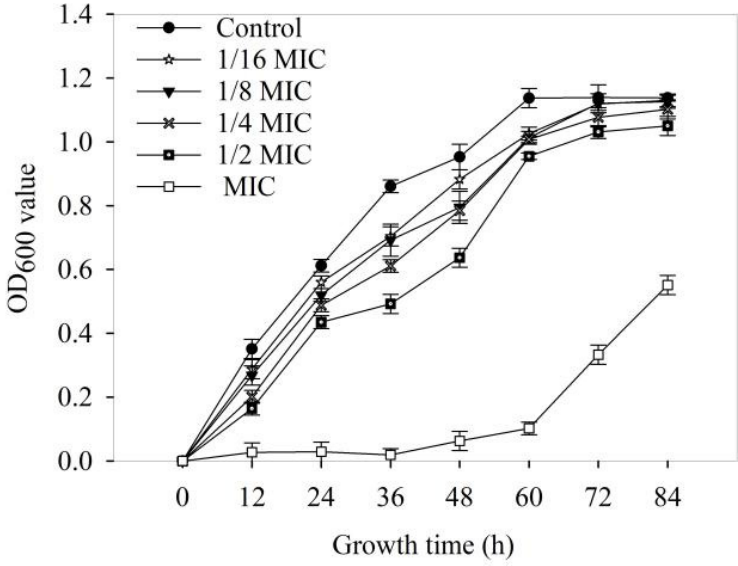
Figure 3. Effects of 4-allylbenzene-1,2-diol on the growth of Xoo.